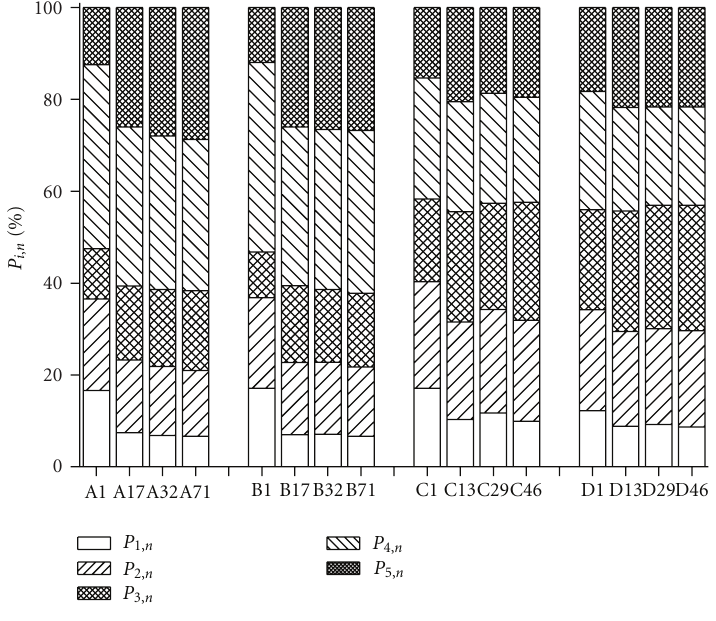
Figure 3: Evolution of the percentage fluorescence response ( P i , n ) during